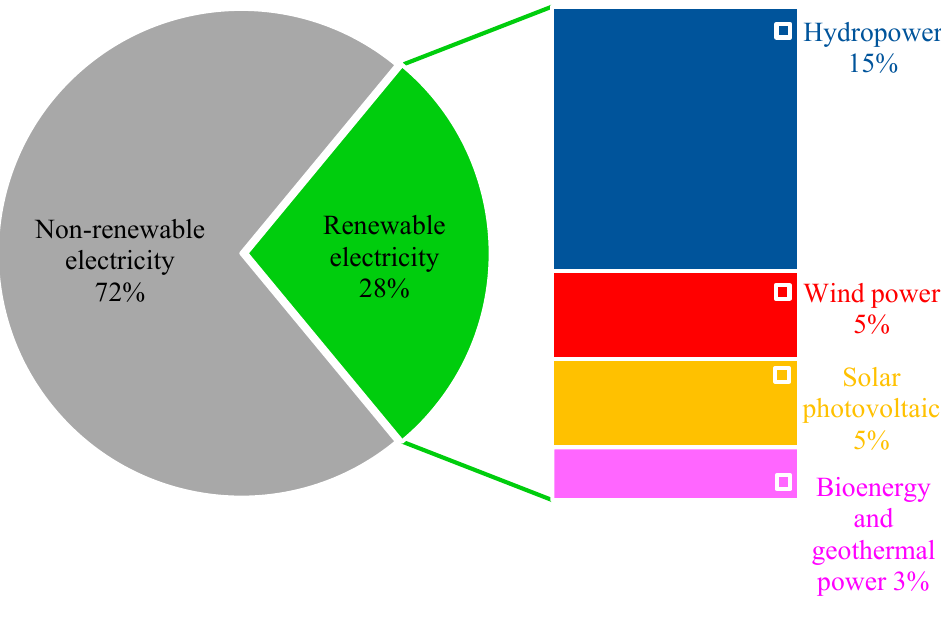
Figure 1. Worldwide wind power share of global electricity production in 2021 [4].